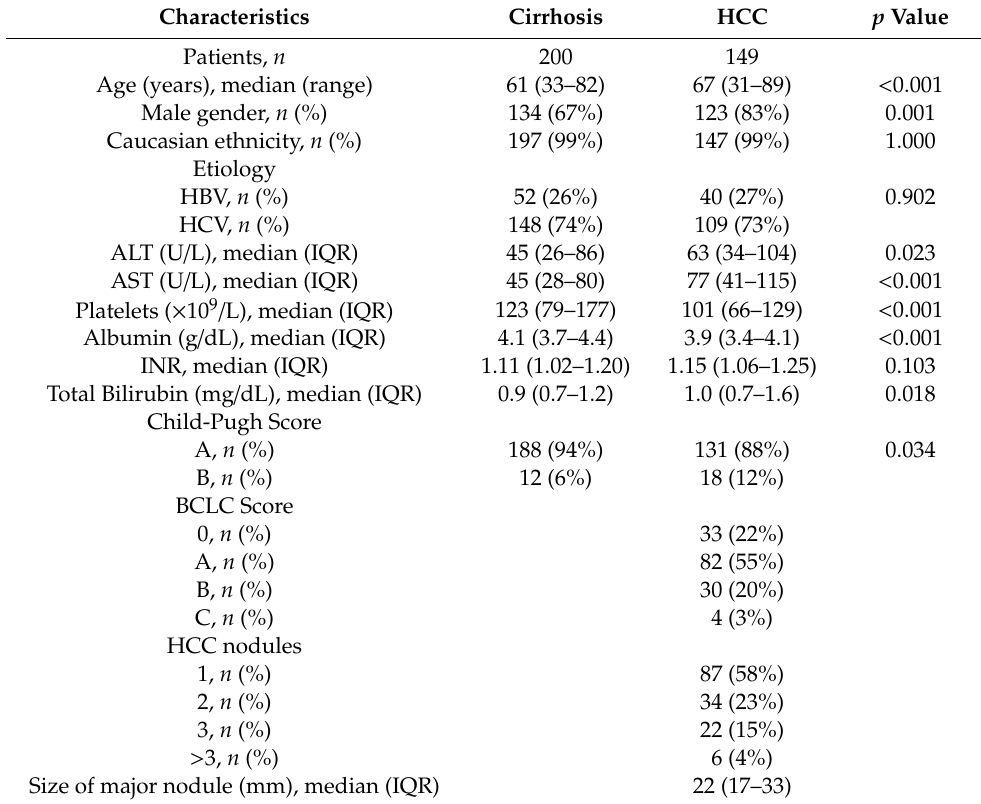
Table 1. Characteristics of the patients included in the study according to the diagnosis of hepatocellular